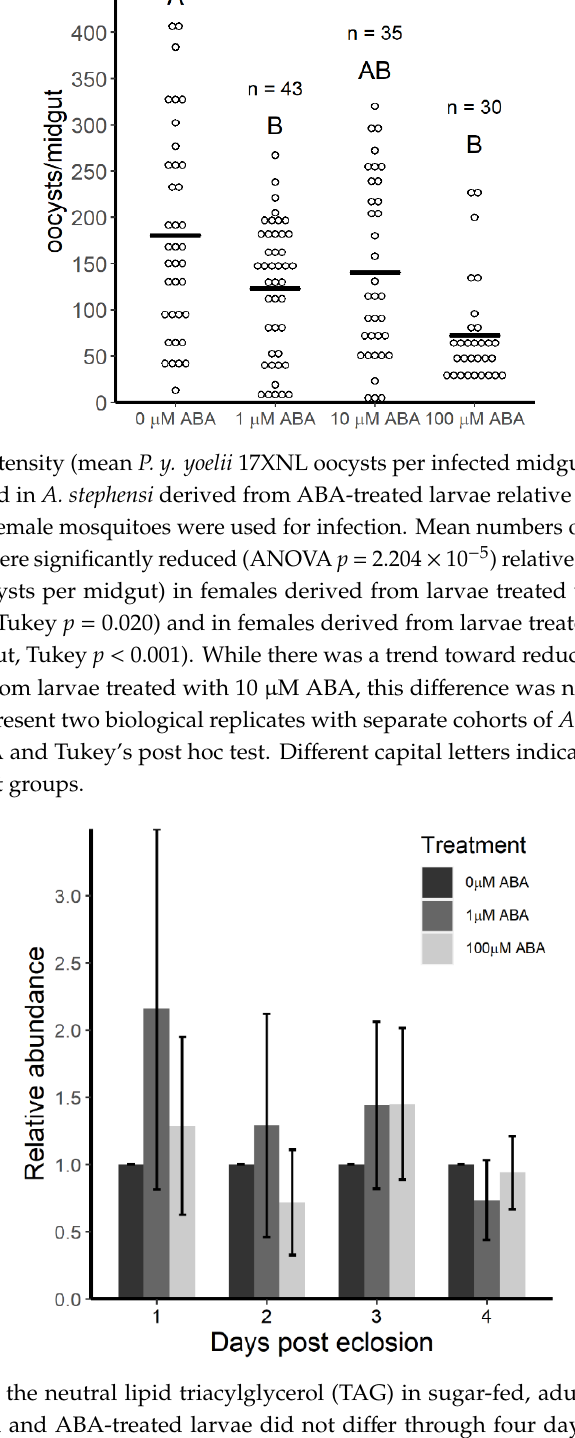
6 of 14 Figure 1. Proportions of female A. stephensi infected with at least one P. y. yoelii 17XNL oocyst were reduced in mosquitoes derived from ABA-treated larvae relative to controls. For these studies, 3–5